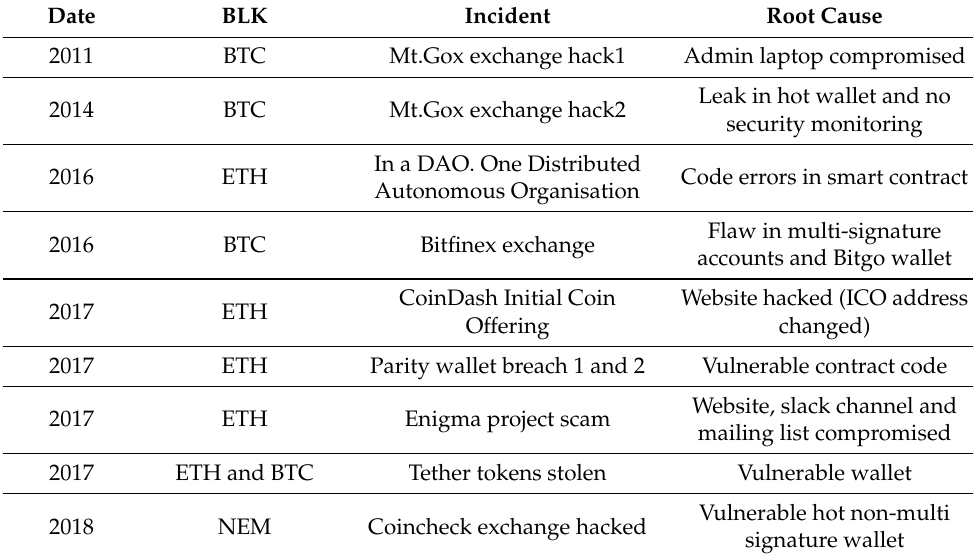
Table 7. Security incidents affecting public